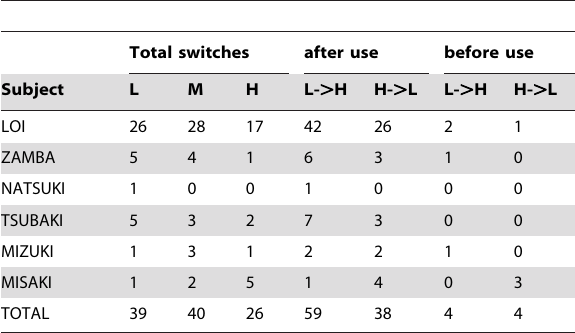
Table 3. Number of total switches observed as a function of hammer weight (L =300 g, M=600 g, H=1200 g) and the direction of switches (L- . H =from lighter to a heavier; H- . L=from heavier to lighter) in Experiment 1.